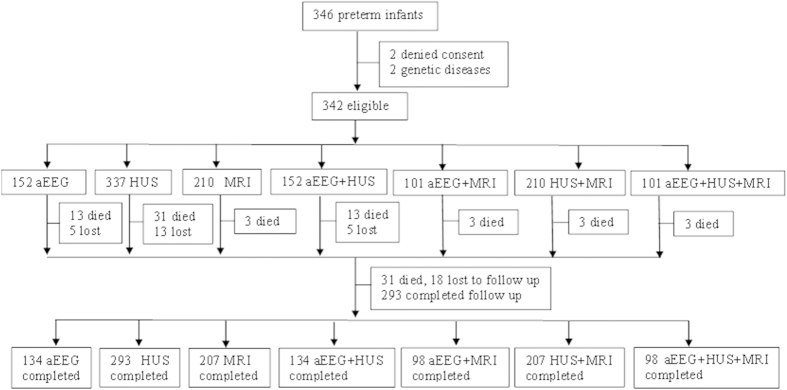
Study flow.A schematic flowchart describing the recruitment and neurodevelopmental follow-up evaluation from birth to 18 months of corrected age for the preterm infants. Lost to follow-up means that contact with the family was lost during the follow-up period. aEEG: amplitude-integrated electroencephalography; HUS: head ultrasonography; MRI: magnetic resonance imaging.